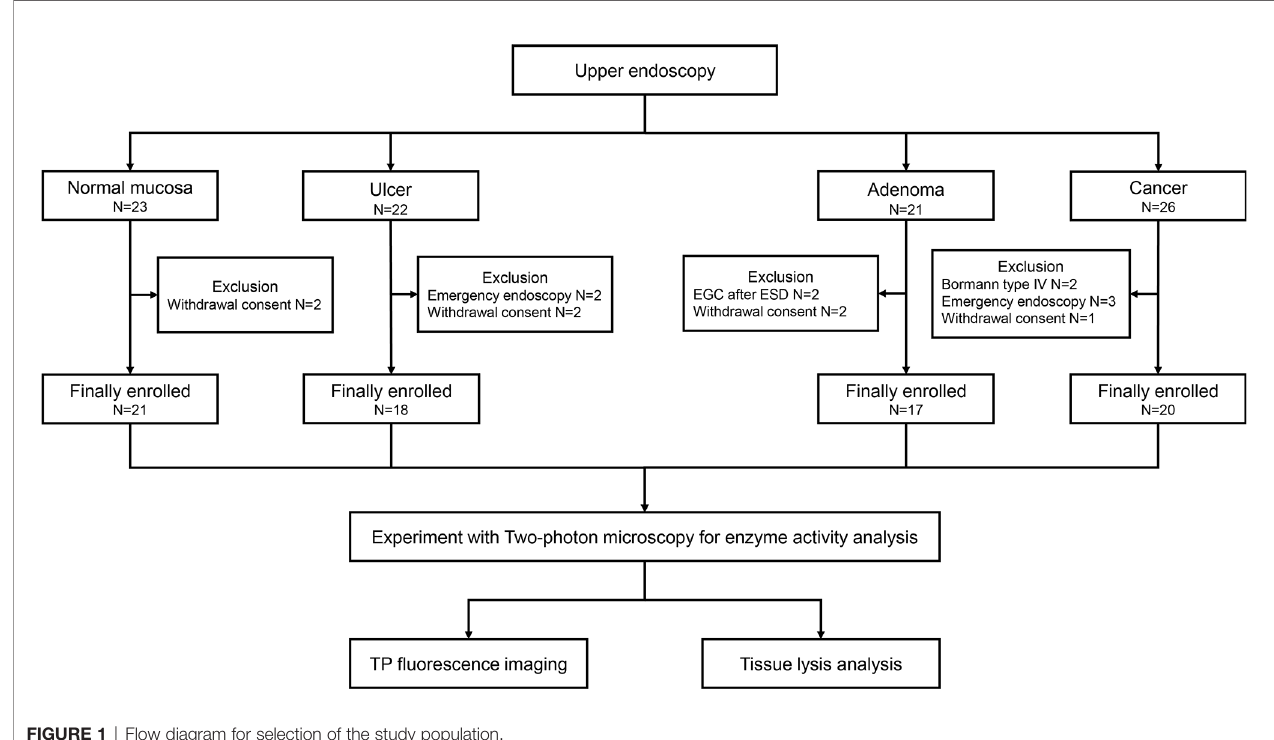
FIGURE 1 | Flow diagram for selection of the study population.